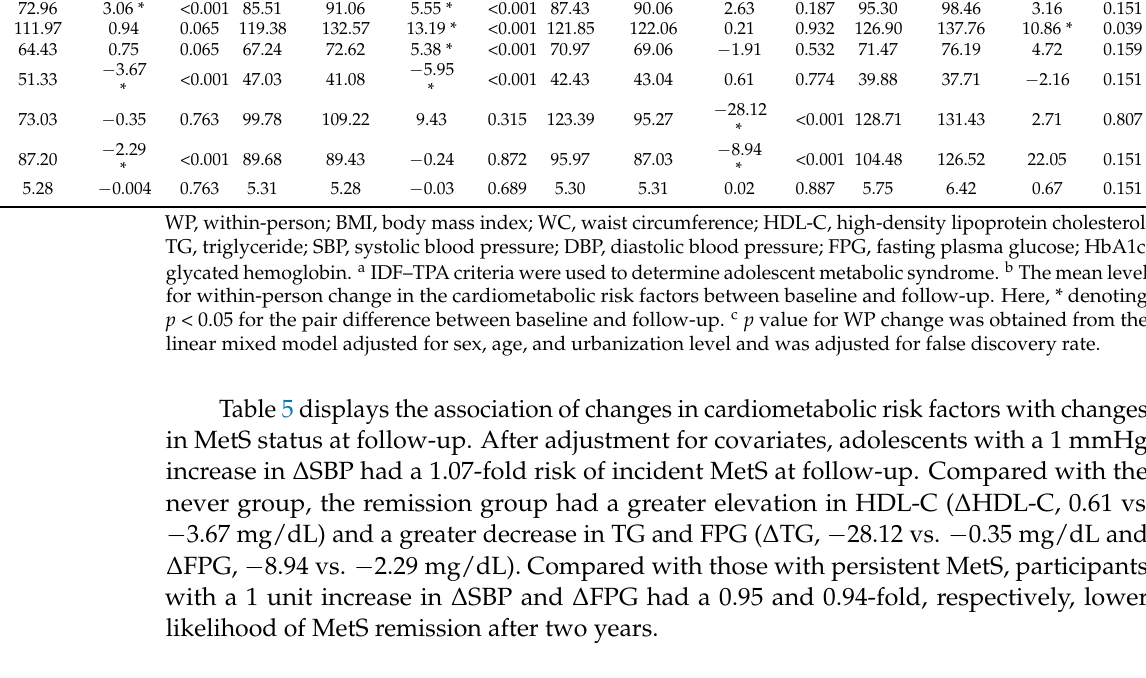
Table 5. Adjusted associations of the changes in cardiometabolic risk factors over 2 years of follow-up with incident, remitted, and persistent metabolic syndrome a in